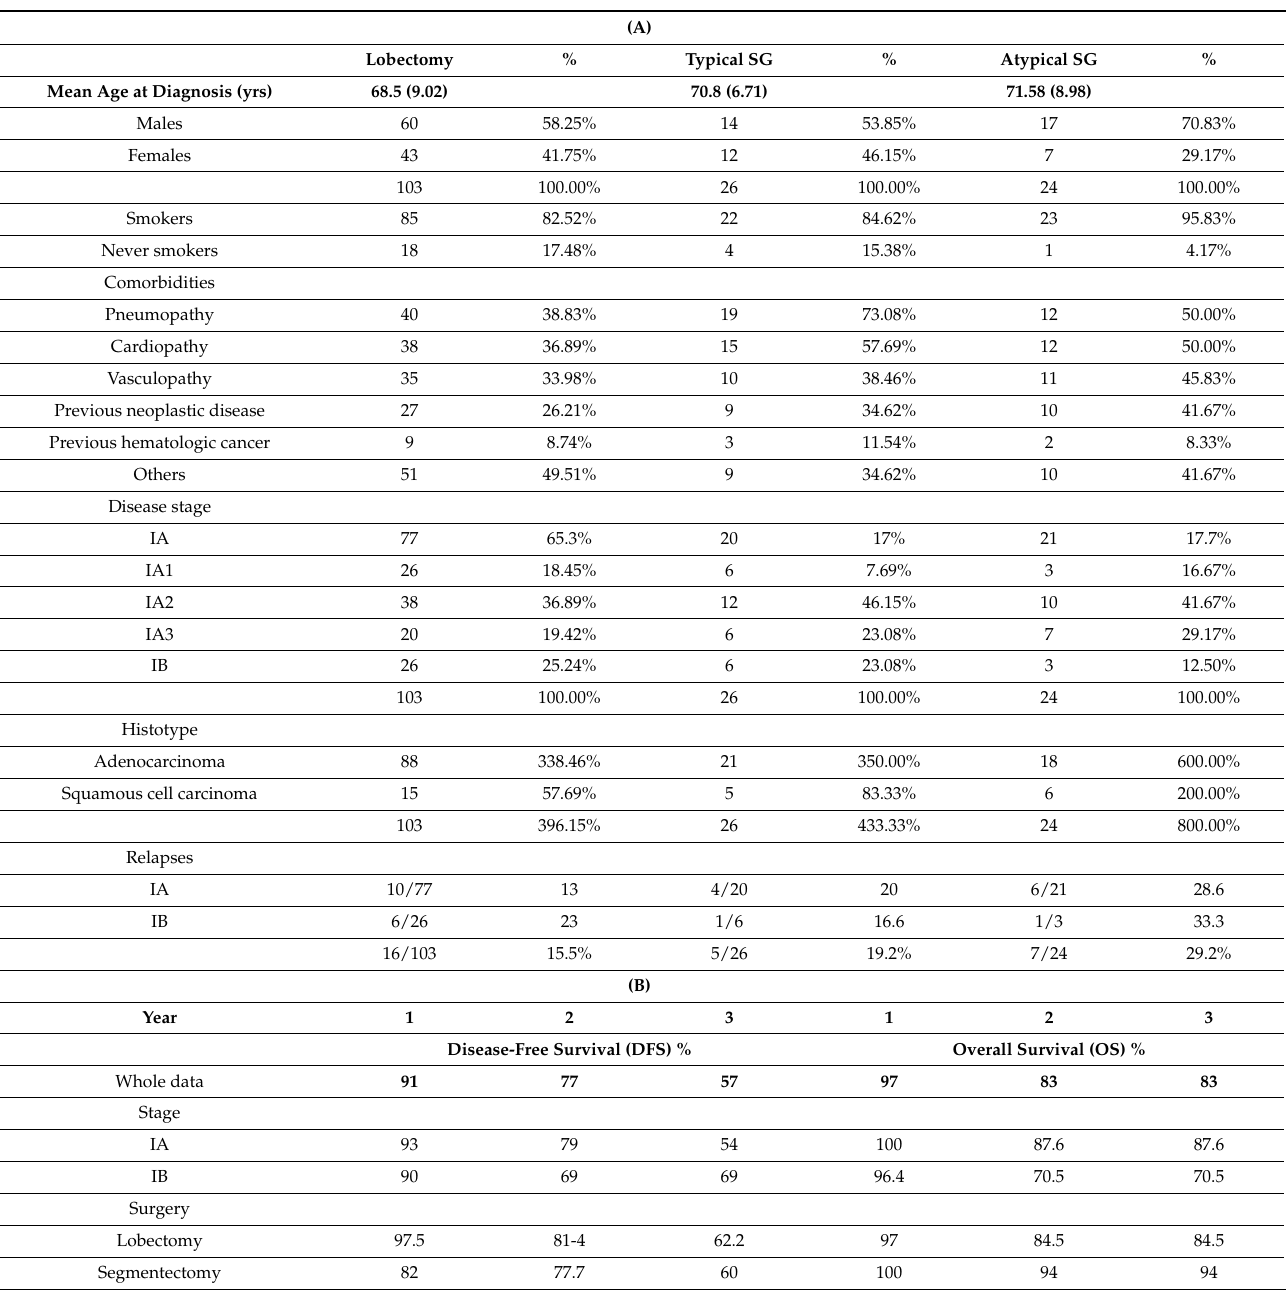
Table 1. ( A ) Demographics and clinical and pathologic details of the three cohorts analyzed. ( B ) Disease-free survival (DFS) and overall survival (OS) data defined for the 1st, 3rd, and 5th year of follow-up for all the enrolled patients according to the Kaplan–Meier